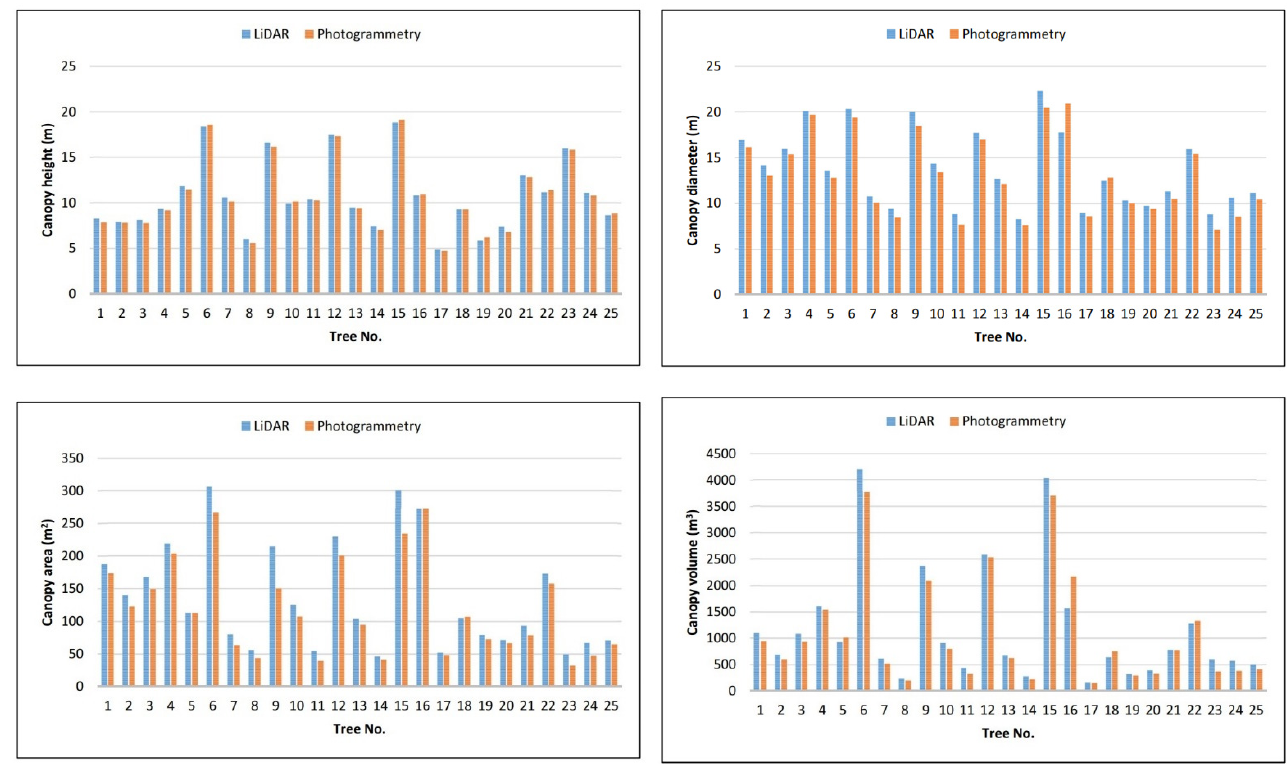
Figure 14. Comparison of tree canopy parameters.